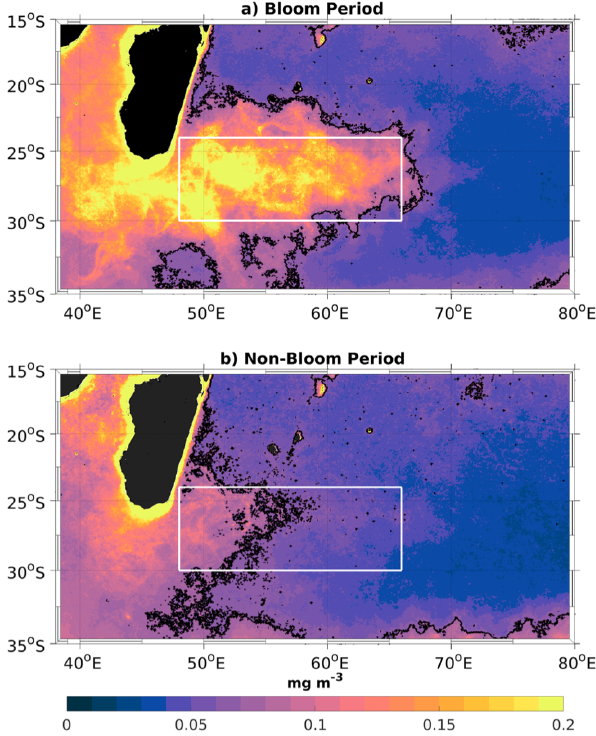
Figure 12. (a) Spatial maps of mean Chl a concentration (mgm − 3 ) during months of maximum austral summer bloom. (b) The same as (a) but during January showing the minimum Chl a concentra- tion in austral summer. The black contour denotes the 0.07mgm − 3 threshold used to distinguish between bloom and non-bloom years. From Dilmahamod et al.